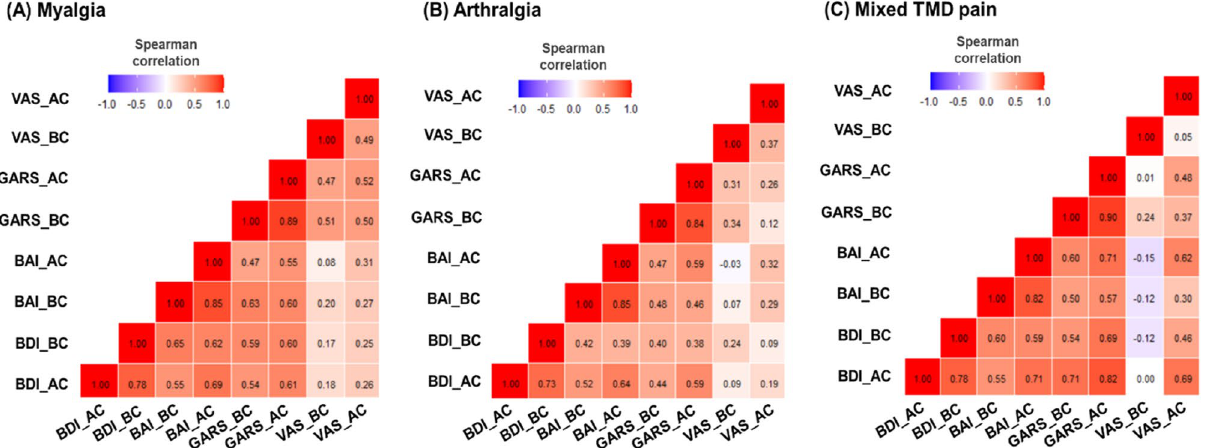
Figure 3. Correlation of Beck Depression Inventory (BDI), Beck Anxiety Inventory (BAI), Global Assessment of Recent Stress (GARS), and Visual Analog Scale (VAS) in TMD pain subgroups. Results were obtained via Spearman’s correlation analysis. TMD, temporomandibular disorder; BDI, Beck Depression Inventory; BAI, Beck Anxiety Inventory; GARS, Global Assessment of Recent Stress; VAS, visual analog scale; BC: before COVID-19, AC: after COVID-19, BC, total score in BC; AC, total score in